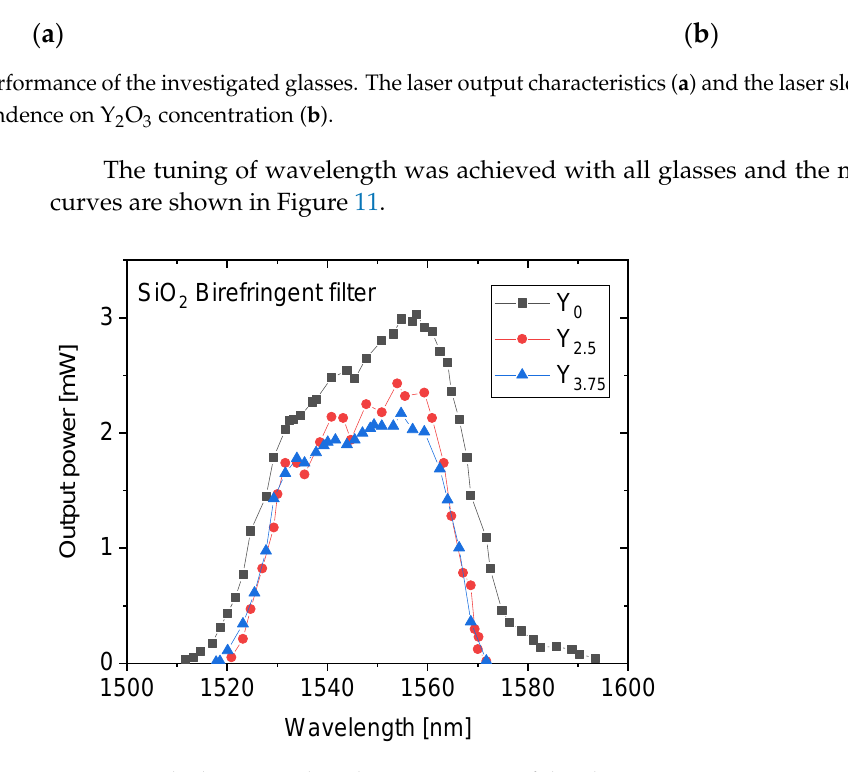
Figure 11. The laser wavelength tuning curves of the glasses. The notches in the tuning curves are due to the absorption lines in the air. The wavelength tuning range of 82 nm (1511–1593 nm) of the Y 0 sample decreases down to 54 nm (1518–1572 nm) with the addition of Y 2 O 3 . This trend seems to follow the dependence of fluorescence spectra width on Y 2 O 3 content. The captured transverse intensity output beam profiles for maximum pumping are shown in Figure 12. The profiles of all samples are close to Gaussian shape, but they also contain higher-order resonator modes, and the pure basic TEM 00 mode was not achieved. This could be due to the inhomogeneous structure of the samples and not the optimum overlap of the pump beam with the resonator